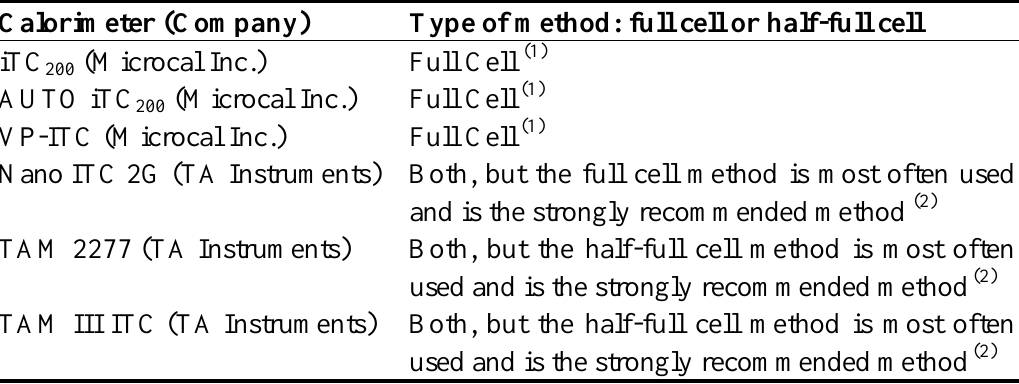
Table 1. Isothermal titration calorimeters that are currently manufactured and the method employed by each (full cell or half-full